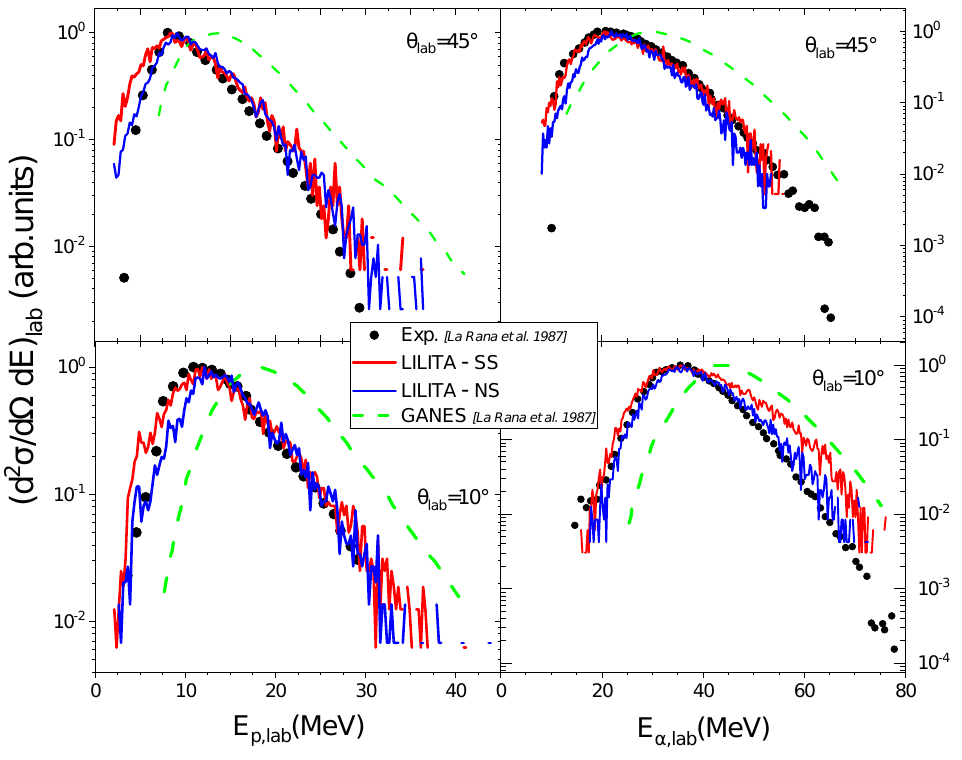
Figure 1. Proton and α -particle energy spectra. The experimental data (dots) from [12] are compared with LILITA_N21 calculations using the SS (solid red line) and NS (solid blue line) and the GANES calculations (dashed green line) assuming emission from spherical nuclei, data from [12]. For more details, see the